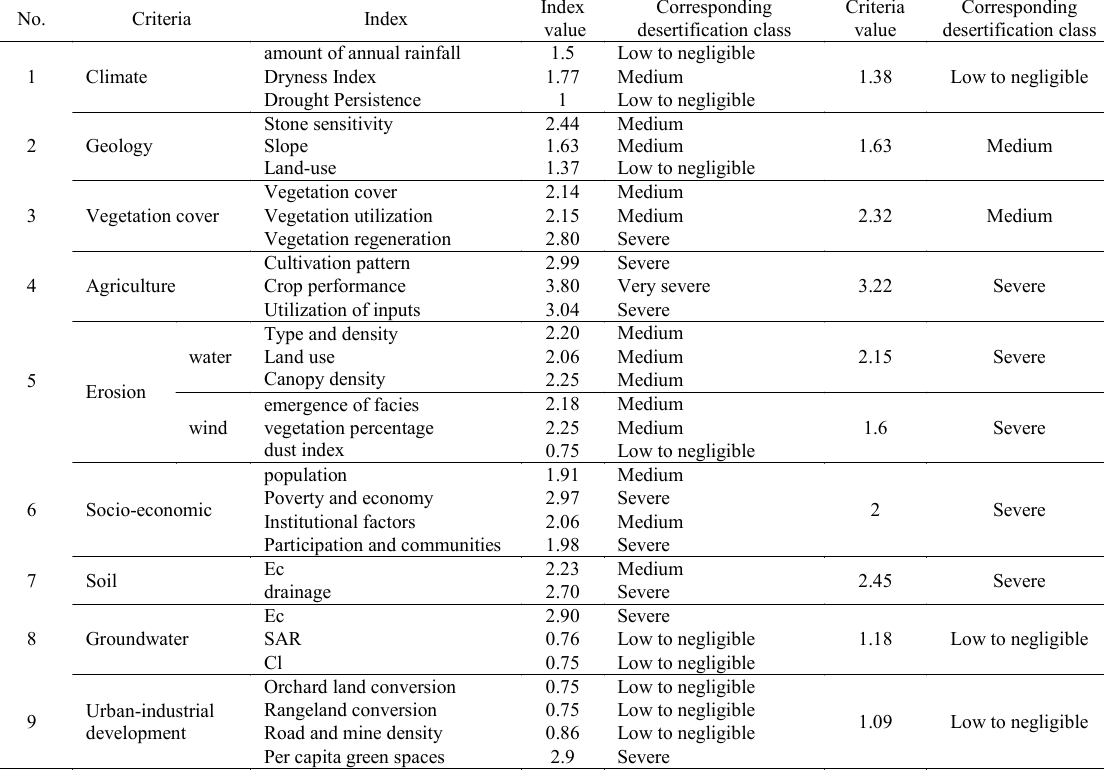
Table 10: The weighted average values of the criteria and classes of desertification intensity severity No.